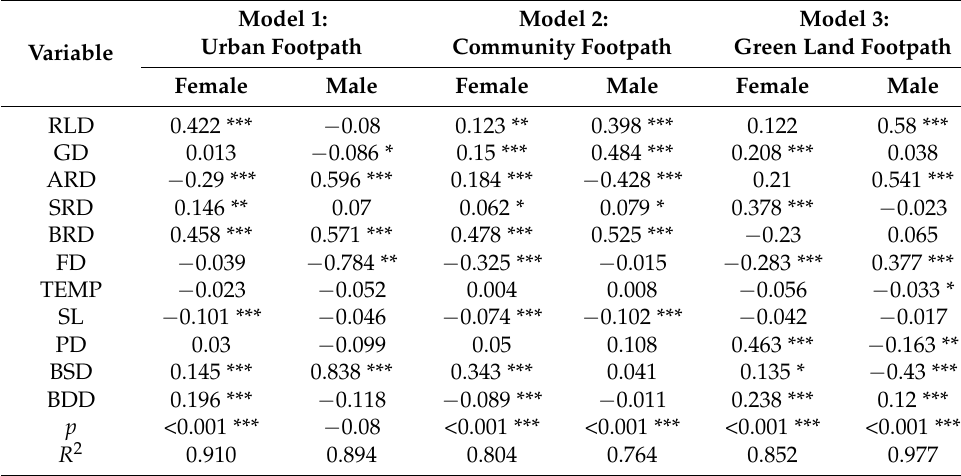
Table 6. Effect of different footpath environments on JA in different gender